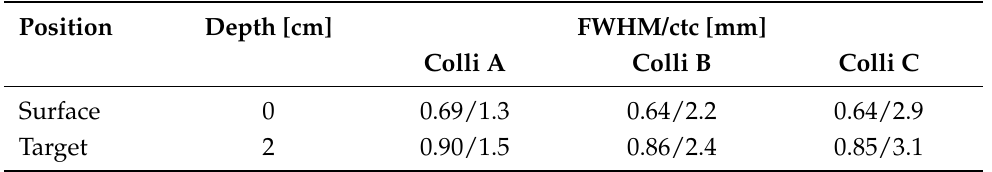
Table 3. Full width at half maximum (FWHM) and spacing between central minibeams stated as refers to the depth in